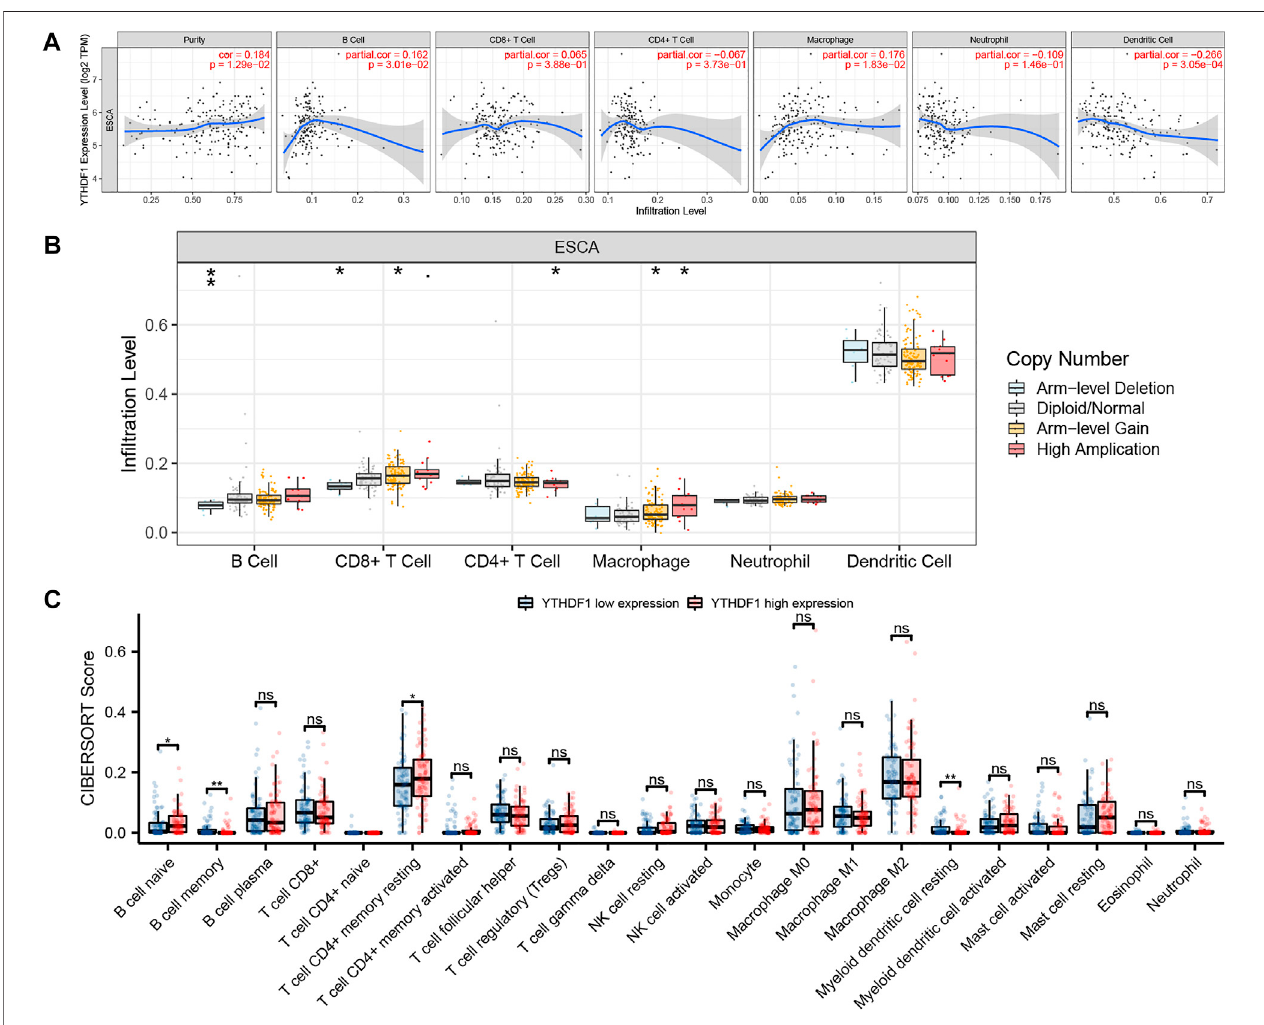
FIGURE 6 | Correlation between YTHDF1 and tumor immune in fi ltrating cells. (A) Correlation between YTHDF1 expression and six types of immune cell in fi ltration of esophageal carcinoma (ESCA). (B) The relation between YTHDF1 copy number variation (CNV) and immune in fi ltration. (C) Changes of 22 immune cell subtypes between the high and low YTHDF1 expression groups in ESCA tumor samples. * p < 0.05; ** p < 0.01; *** p < 0.001; ns, no signi fi